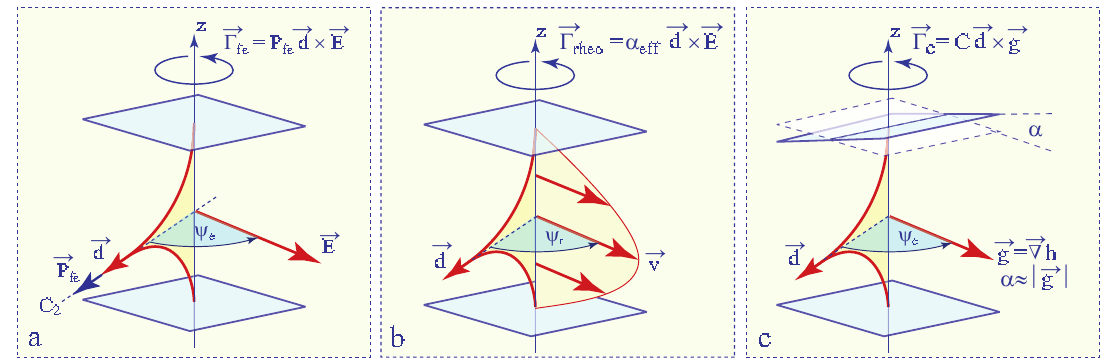
Figure 2. Tropisms of the dowser texture. ( a ) Electrotropism: coupling of the field d , via flexo-electric polarisation, with the electric field E [8]. ( b ) Rheotropism: hydrodynamic torque exerted on the field d by a Poiseuille flow [9]. ( c ) Cuneitropism: coupling of the field d with the thickness gradient g